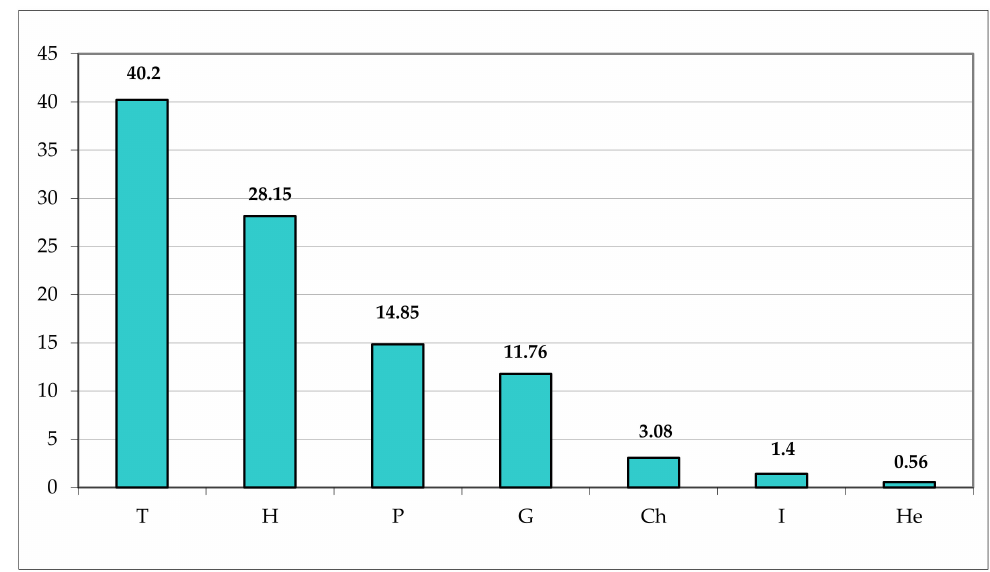
Figure 37. Percentage (axis x) of plant life form spectra of the vascular flora of Appia Antica Regional Park. T: therophytes; H: hemicryptophytes; P: phanerophytes; G: geophytes; Ch: chamaephytes; I: idrophytes; He: helophytes.